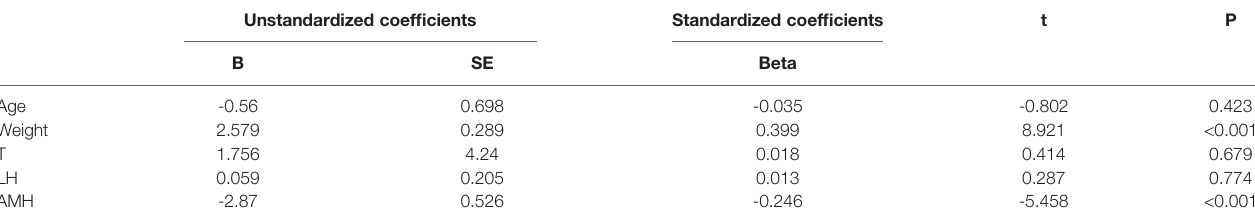
TABLE 4 | Multiple linear regression analysis of initial Gn